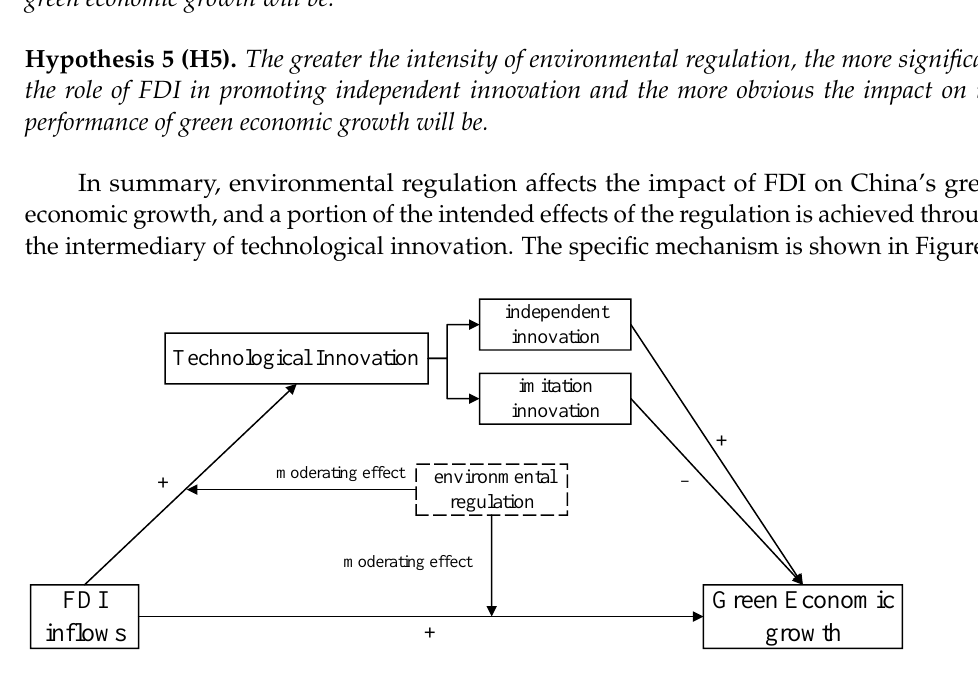
Figure 1. The mechanism of FDI’s influence on green economic growth.